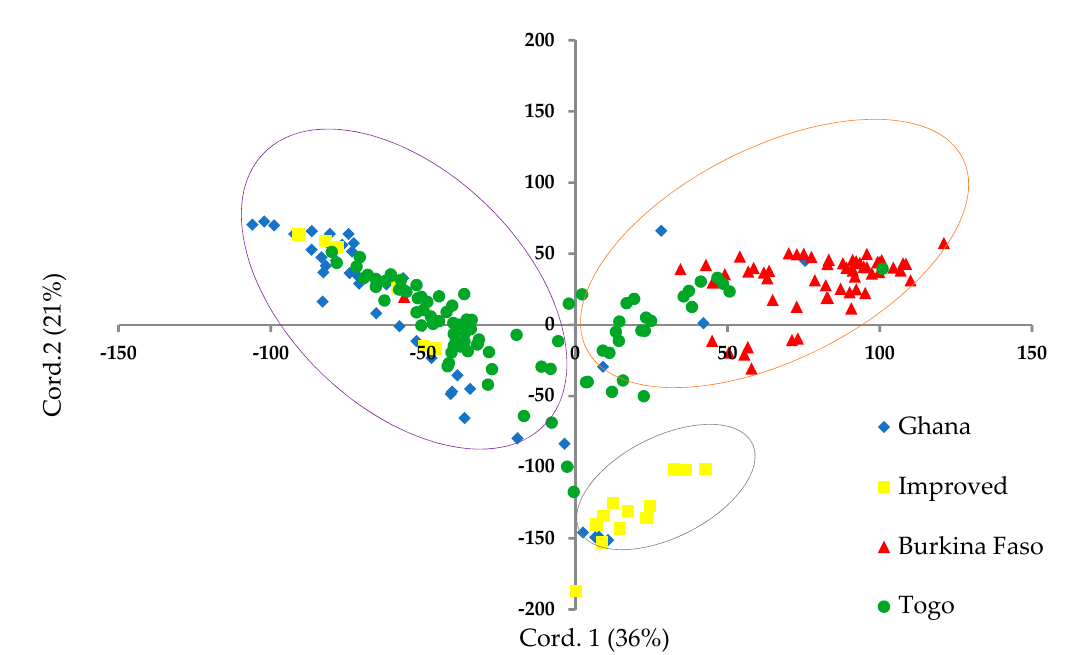
Figure 4. Cluster analysis of 208 maize accessions using principal coordinate analysis (PCoA). Accessions are colored according to origin. The orange, ash, and violet circles represent subpopulation 1, 2, and 3, respectively.